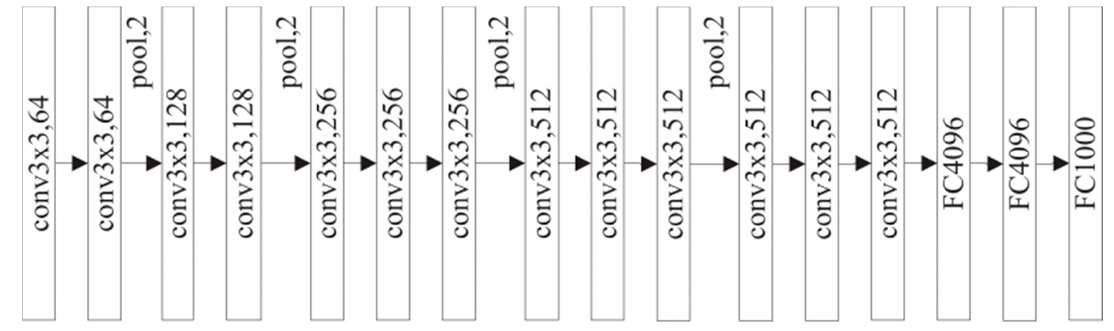
Figure 2. Structure diagram of Visual Geometry Group 16 layers (VGG16).